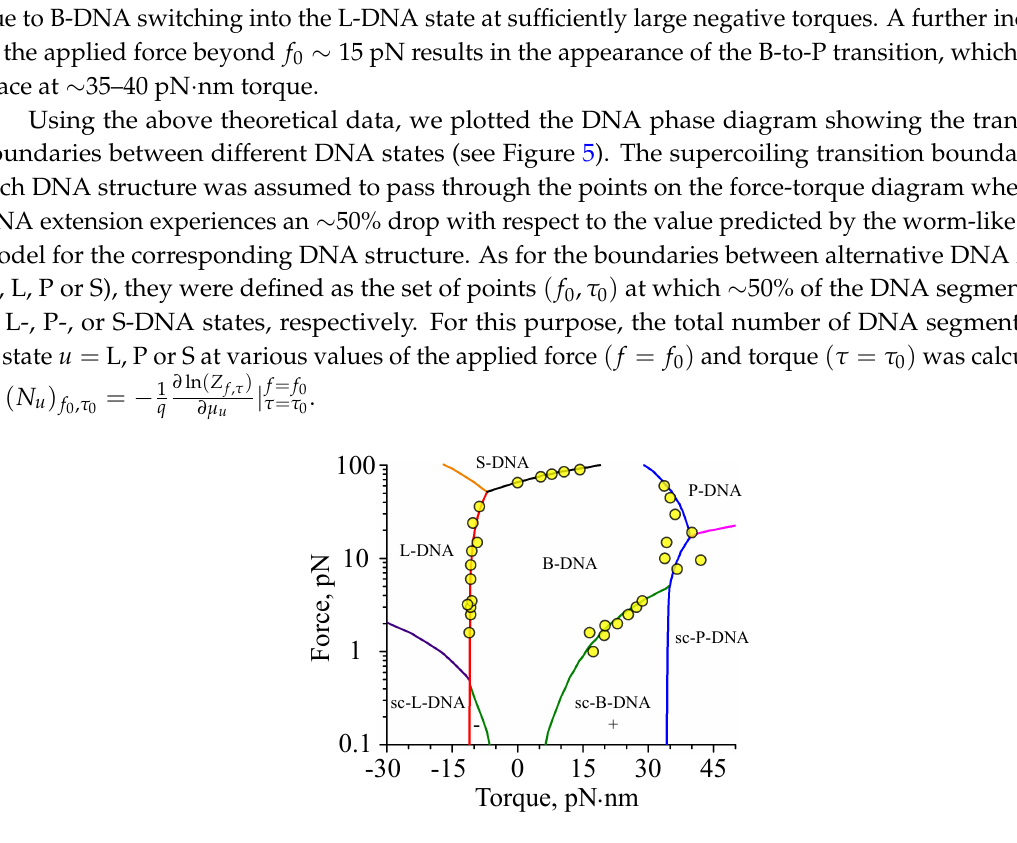
Figure 5. DNA phase diagram. Solid curves indicate transition boundaries between extended (B, L, P, S) and supercoiled (sc-B, sc-L, sc-P) states of DNA predicted by the transfer-matrix calculations. The resulting phase diagram demonstrates good agreement with the existing experimental data (circles), which were digitized from